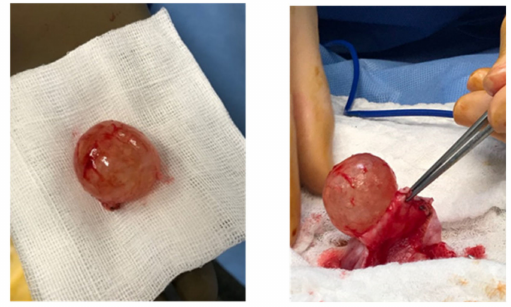
Figure 2. Photograph of a 3 cm recurrence of serous BOT resected after small